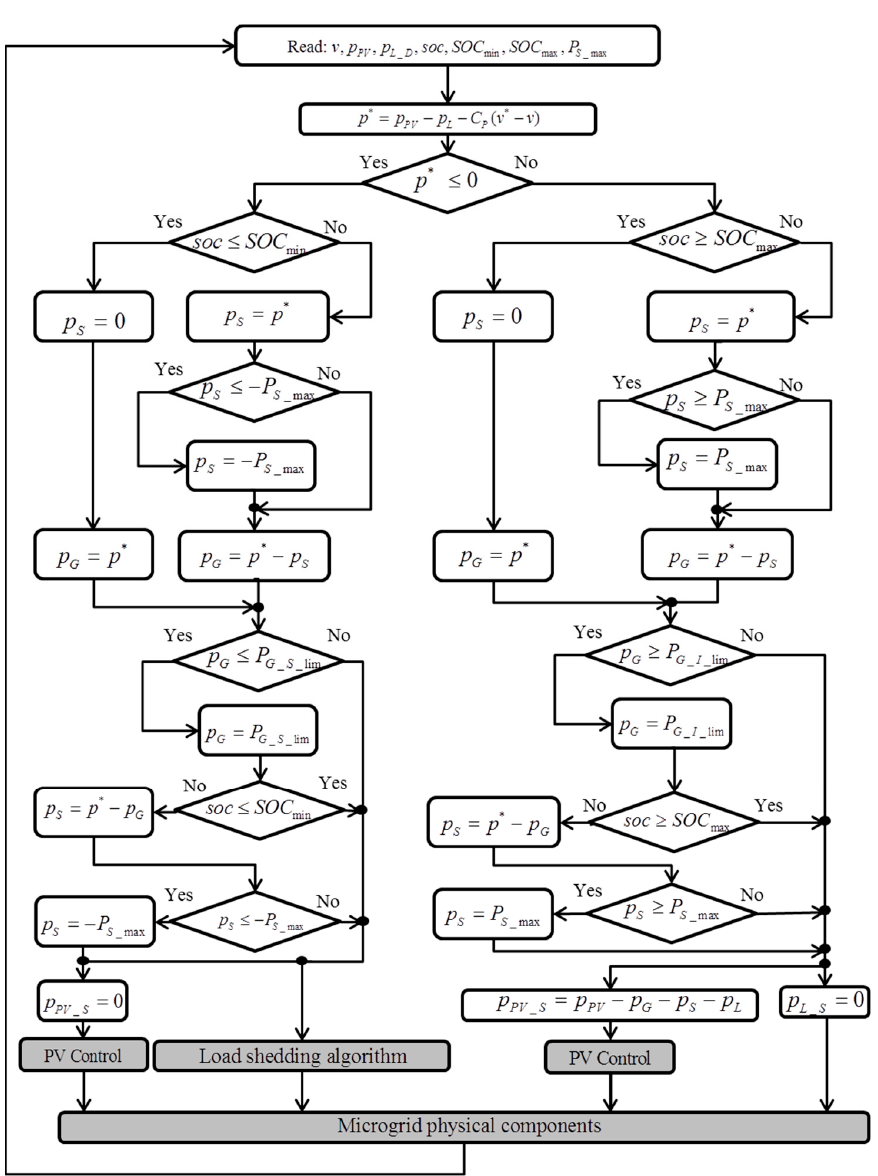
Figure 4. Operational algorithm considering the storage priority strategy.